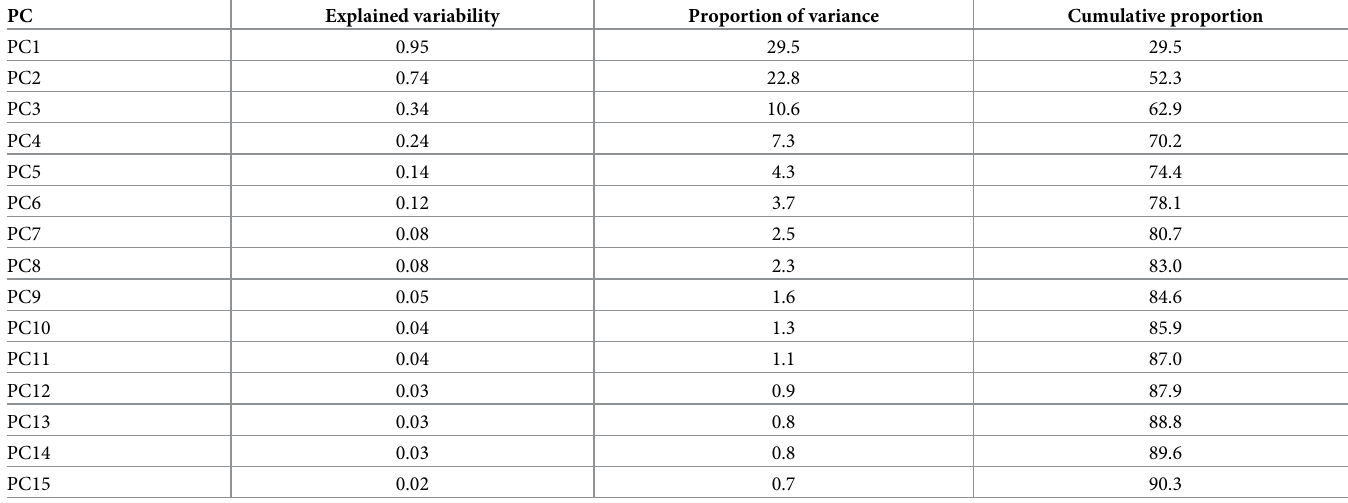
Table 3. Variability report of the first 15 principal components. Proportion of variance and cumulative proportion are percentages. PC stands for principal component. PC